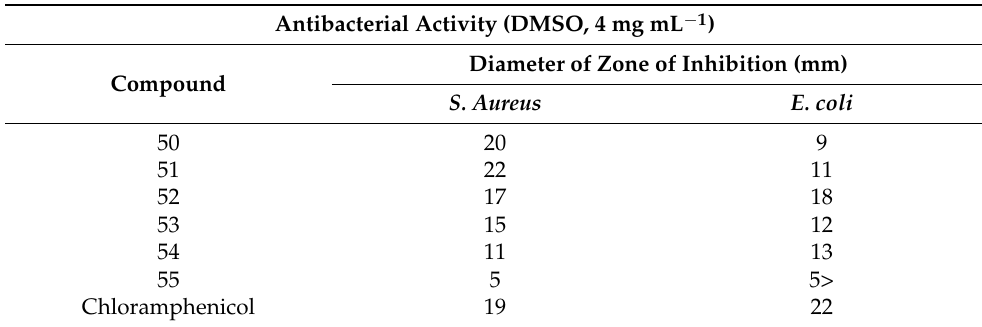
ArylClSO Scheme 2. Synthesis of substituted quinoxaline sulfonamide derivatives, with structure 49. Table 2. Antibacterial activity of quinoxaline benzene sulfonamide derivatives 50 – 55